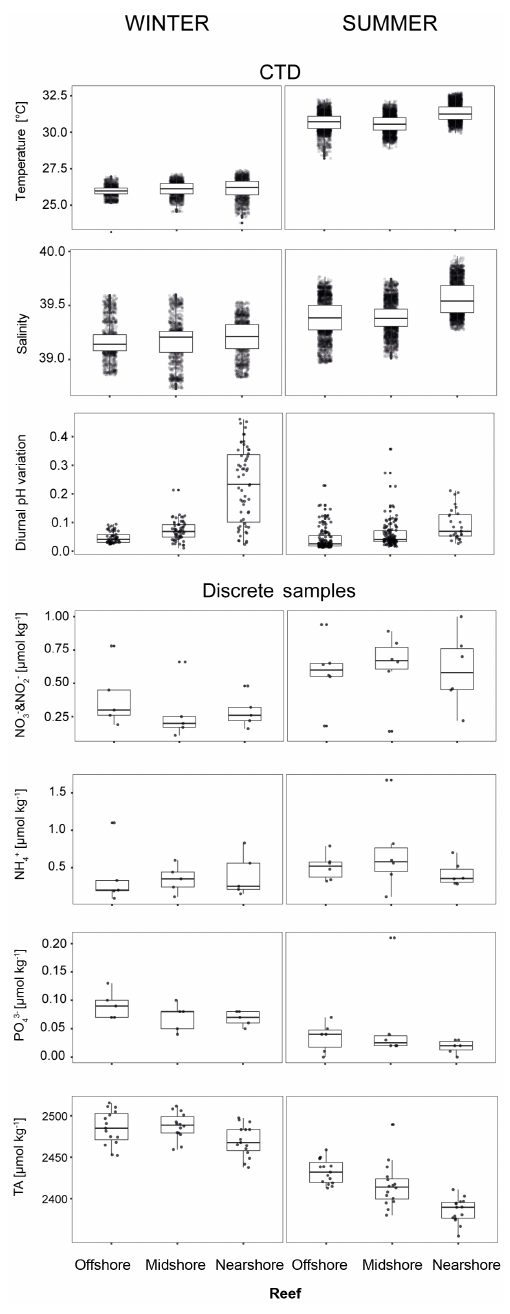
Figure 4. Abiotic conditions in the reef sites. Temperature, salin- ity, and diurnal pH NBS variation ( = diurnal standard deviations) were measured continuously over the respective seasons by CTDs (conductivity–temperature–depth loggers including an auxiliary pH probe). Inorganic nutrients and total alkalinity (TA) were measured in discrete samples across reef sites and seasons. Boxplots illus- trate the differences of seawater parameters between the reefs within each season (box: 1st and 3rd quartiles; whiskers: 1.5-fold inter- quartile range; points: raw data scatter).